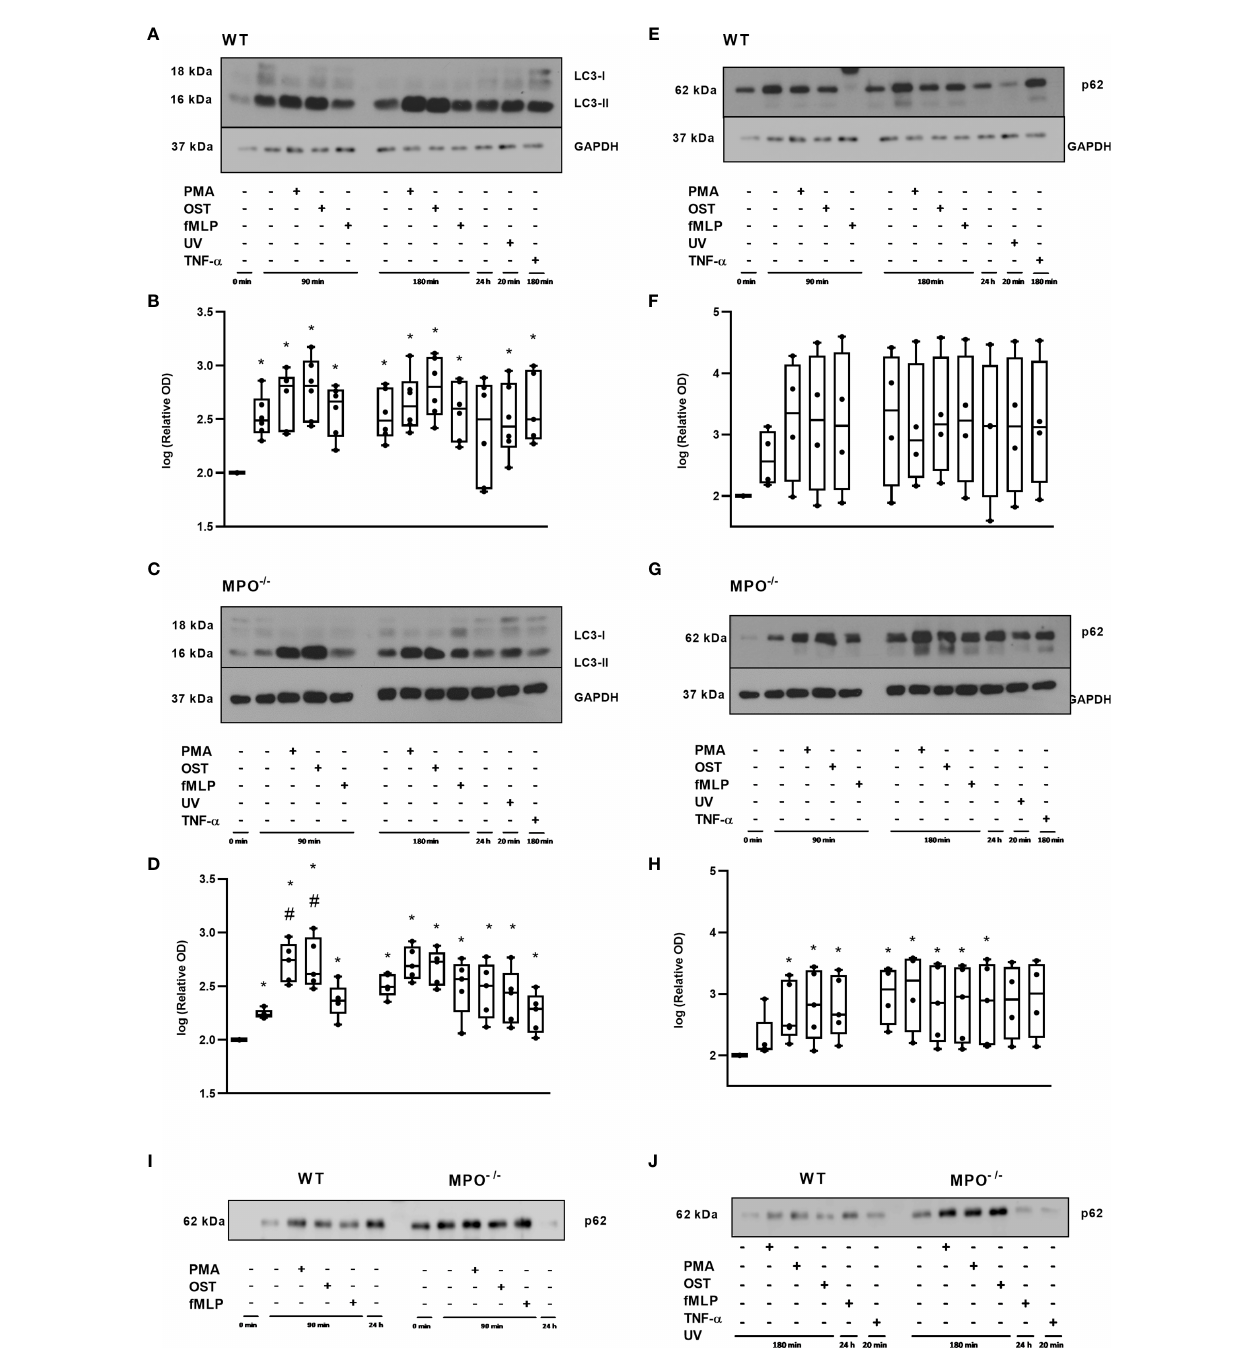
FIGURE 6 | Autophagic proteins LC3 (A – D) and p62 (E – J) in PMNs from WT (A, B, E, F, I, J) and MPO -/- (C, D, G – J) mice after the induction of oxidative burst by PMA, OST, and fMLP for 90 min and 180 min. PMNs (1x 10 7 cells/ml) isolated from BALF of WT and MPO-/- mice were stimulated with PMA (80 nM), OST (1:10 MOI) and fMLP (1.14 m M) for 90 and 180 min. PMNs incubated for 24 h without stimulation, PMNs irradiated by UV for 20 min, and PMNs treated by TNF- a (10 ng/ ml) for 180 min were tested as positive controls. Proteins LC3, p62 and GAPDH (as a marker of equal loading) were determined by Western blot. Analysis of OD was performed using ImageJ, and values are depicted as percentage of control PMNs (untreated and non-incubated) transformed by Log2 to normalize the data distributions (B, D, F, H) . Data are presented as median, 25, and 75 percentiles (the box) and 10 and 90 percentiles (the whiskers), and individual values are drawn as individual dots (n = 4-5). * shows statistically signi fi cant difference (p < 0.05) compared with untreated control (Ctrl). # Shows statistically signi fi cant difference (p < 0.05) compared with unstimulated control incubated for the same time period.A comparions of p62 protein in PMNs from WT and MPO -/- PMNs after the induction of oxidative burst by PMA, OST, and fMLP for 90 min (I) and 180 min (J) . Figures (A, C, E, G, I, J) represent typical